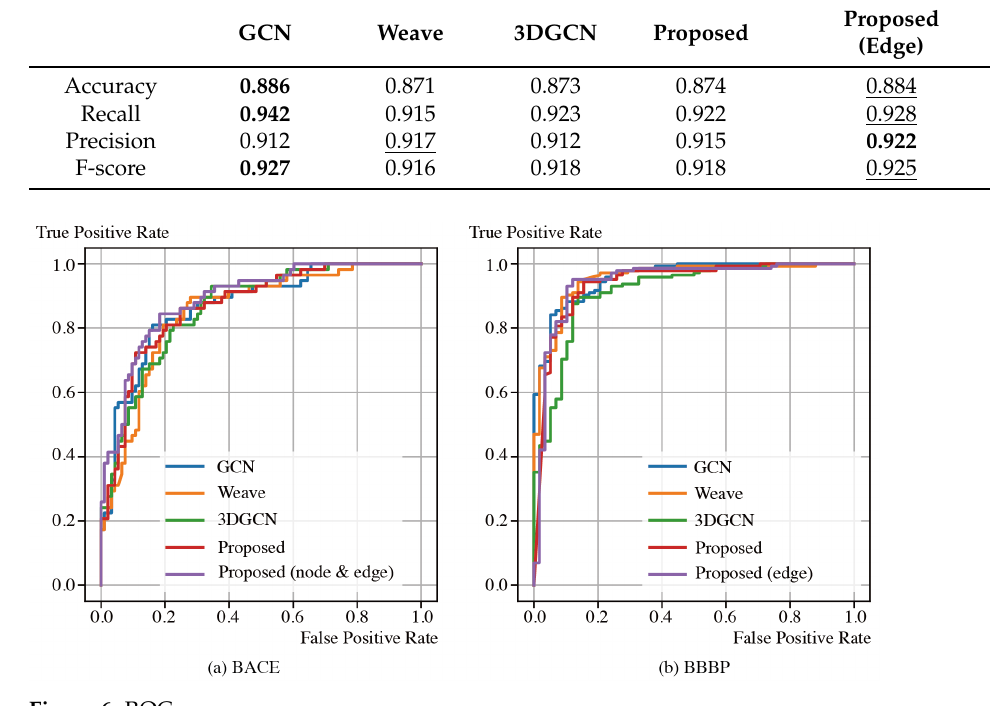
Figure 6. ROC curves.